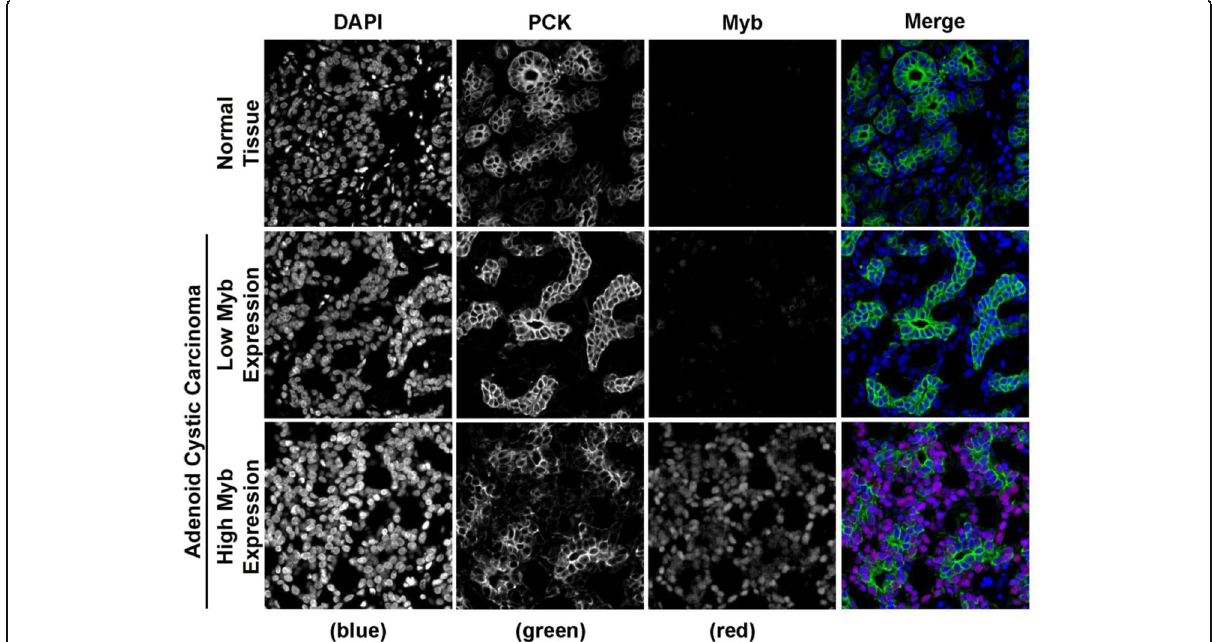
Fig. 3 MYB protein expression. Representative fluorescence microscopy micrographs of paraffin-embedded normal tissue and example of ACC tissues expressing different amount of MYB protein. TMA were subjected to anti-MYB (red) and anti-Pan cytokeratin (green) antibodies indirect immunofluorescence and nuclear counterstaining with DAPI (blue)